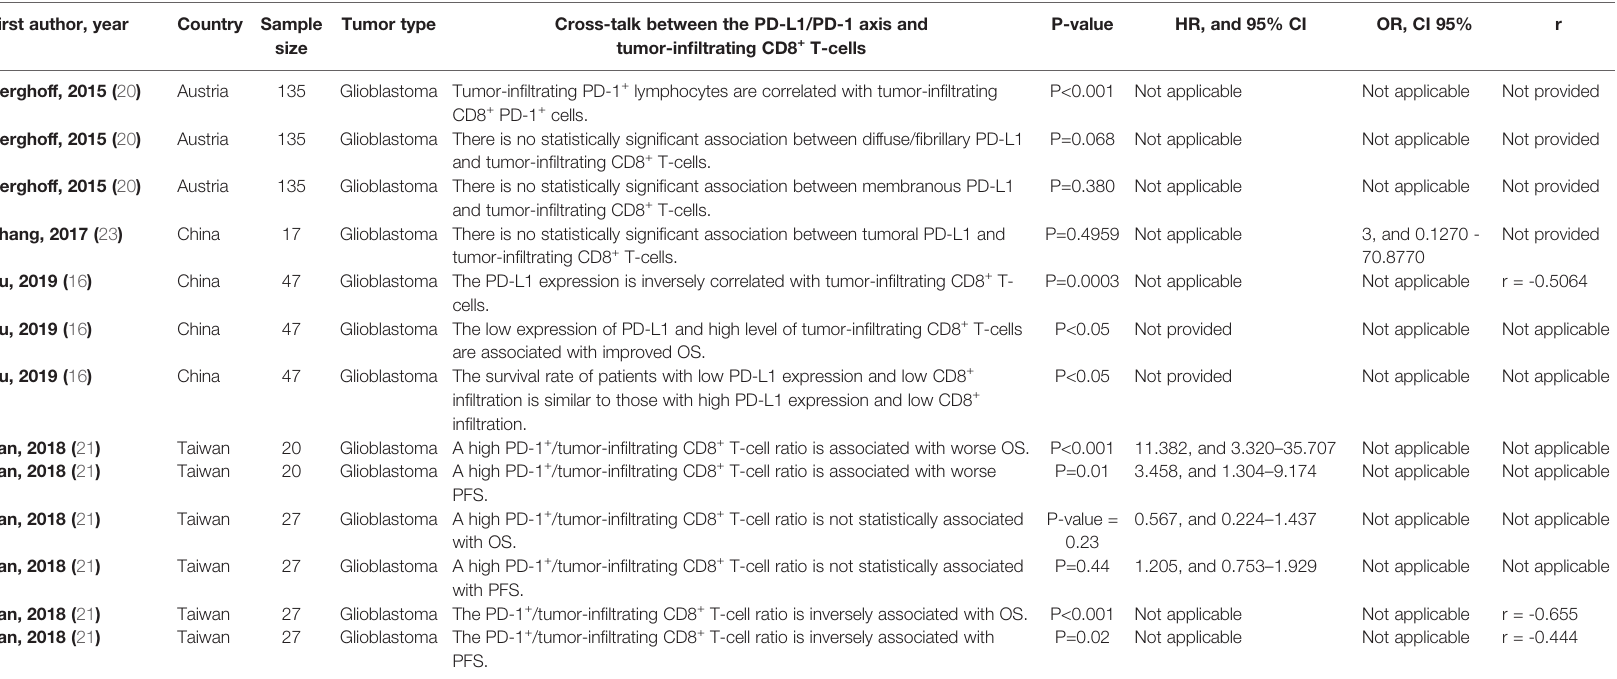
TABLE 4 | The cross-talk between the PD-L1/PD-1 axis and tumor-in fi ltrating CD8 + T-cells in